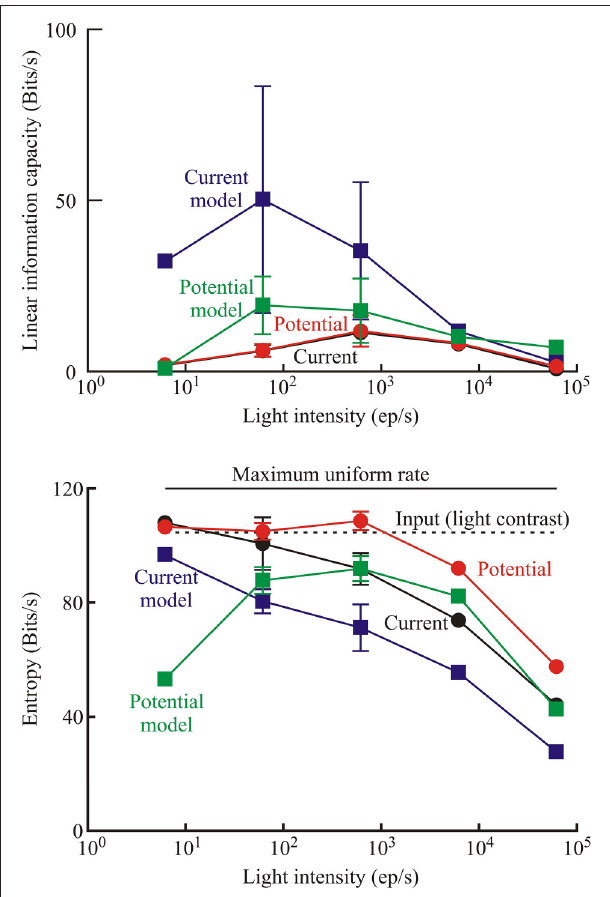
FIGURE 7 | Measures of information transmission by photoreceptors transducing naturalistic stimulation. Upper: linear information capacity calculated from the coherence function between the input and output data for receptor current, receptor potential, and the respective models of current and potential for the Periplaneta receptors as a function of input light intensity. Lower: entropy rates in the photoreceptors measured by data compression for the same signals in the Periplaneta receptors. Numbers of experiments were: 1, 6, 5, 2, and 1 for increasing light levels. Mean values of multiple experiments are shown, and standard deviations are shown for experiments with five and six estimates. All other values represent fitted values to single experiments. Dashed line indicates the entropy rate of the input light signal. Solid upper line shows the maximum entropy rate that could be calculated by this method, corresponding to a uniform distribution of values over the same